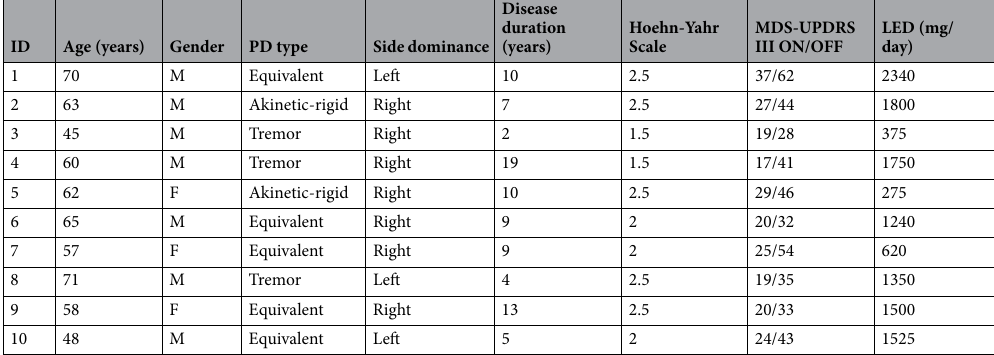
Table 1. Demographics and clinical patient characteristics. The third part of the MDS-UPDRS includes the clinician-scored, monitored motor evaluation (33 scores based on 18 items) 19 , ranging from the worst MDS- UPDRS III score of 132 (= 4.33) points to 0 points (as in healthy individuals). The minimal clinically important difference on the UPDRS motor score is 2.3–2.7 points 20 . For patients 1, 8 and 10, the PD-dominant hand was the left hand, while for all others the PD-dominant hand was the right hand. MDS-UPDRS Movement Disorder Society-Unified Parkinson’s Disease Rating Scale, ON/OFF values of preoperative l-Dopa challenge test, LED preoperative levodopa equivalent dose 18